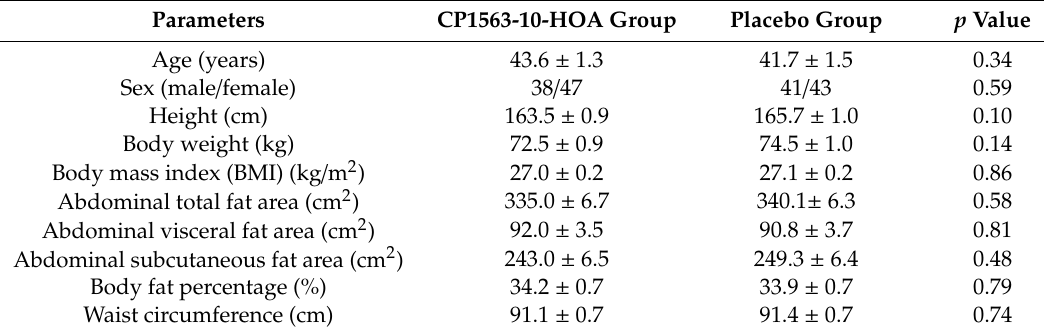
Table 1. Characteristics of